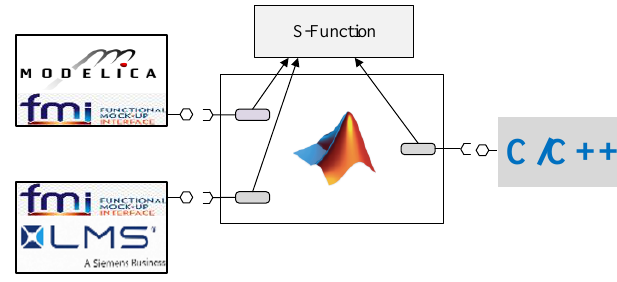
Figure 18. The connections between different tools.